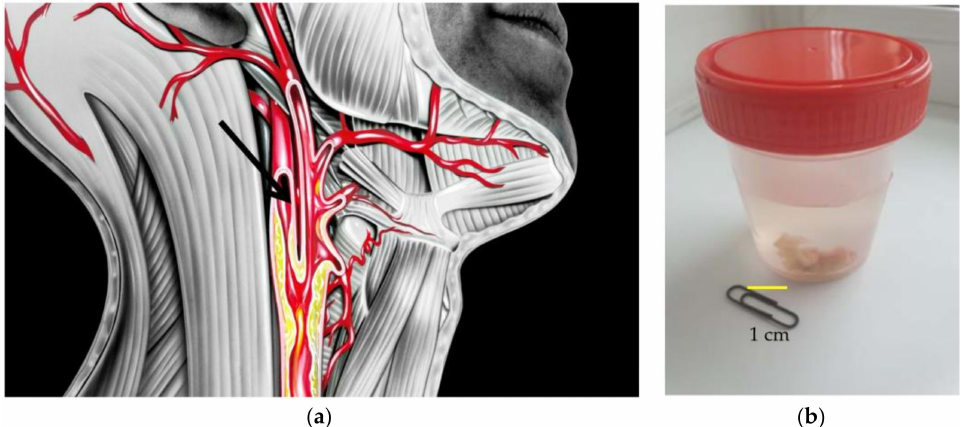
Figure 5. Scheme of the operation of carotid endarterectomy. The black arrow indicates an atheroscle- rotic plaque that is located in the lumen of the carotid artery. ( a ) and general view of atherosclerotic plaque removed from the carotid artery of the patient and placed into saline solution ( b